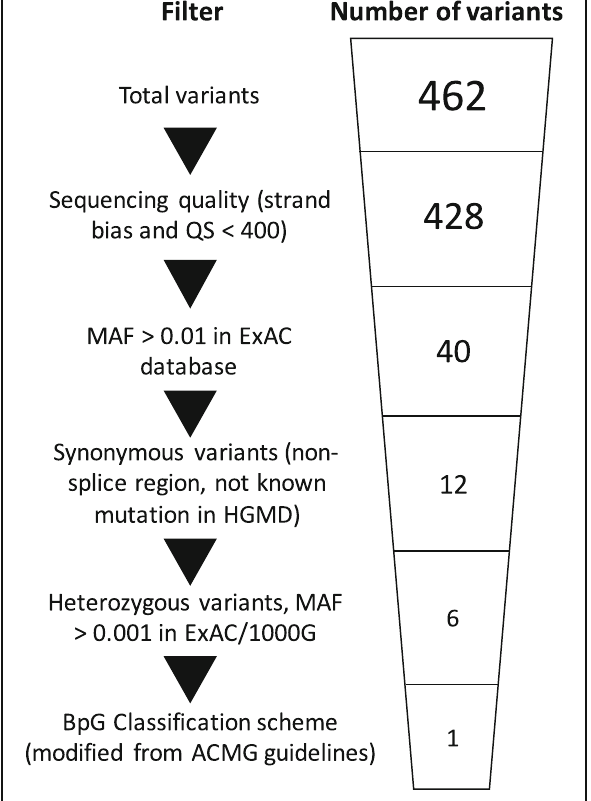
Fig. 1 Overview of the variant filtering scheme. Filters used are listed on the left, and the number of variants on each step are depicted on the right. QS = quality score; MAF = minor allele frequency; ExAC = Exome Aggregation Consortium; HGMD = Human Gene Mutation Database; 1000G = 1000 Genomes Project; BpG = Blueprint